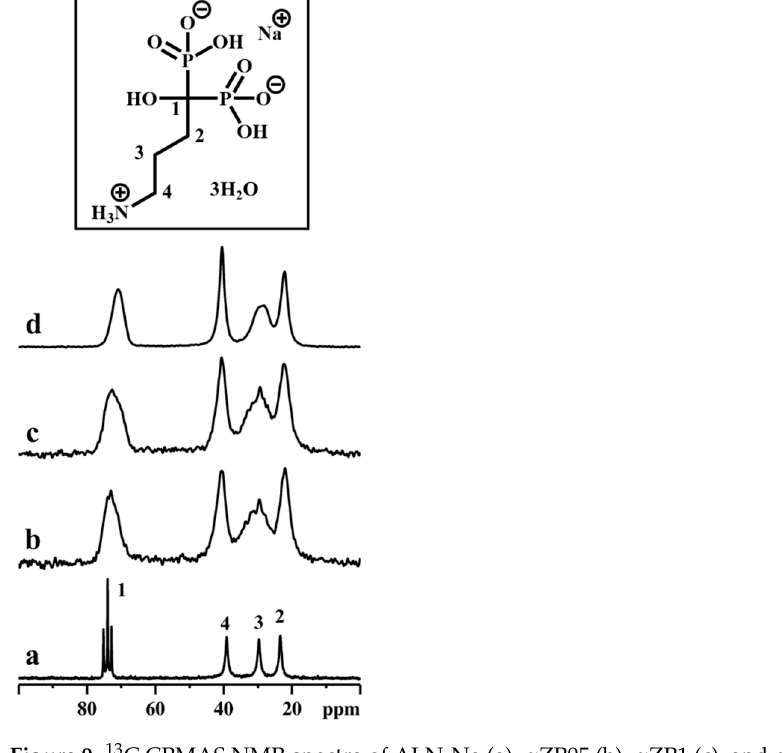
Figure 9. 13 C CPMAS NMR spectra of ALN-Na (a), α ZP05 (b), α ZP1 (c), and α ZP2 (d). Inset shows the molecular structure of ALN-Na. A MAS rate of 10 kHz was employed during the experiments.